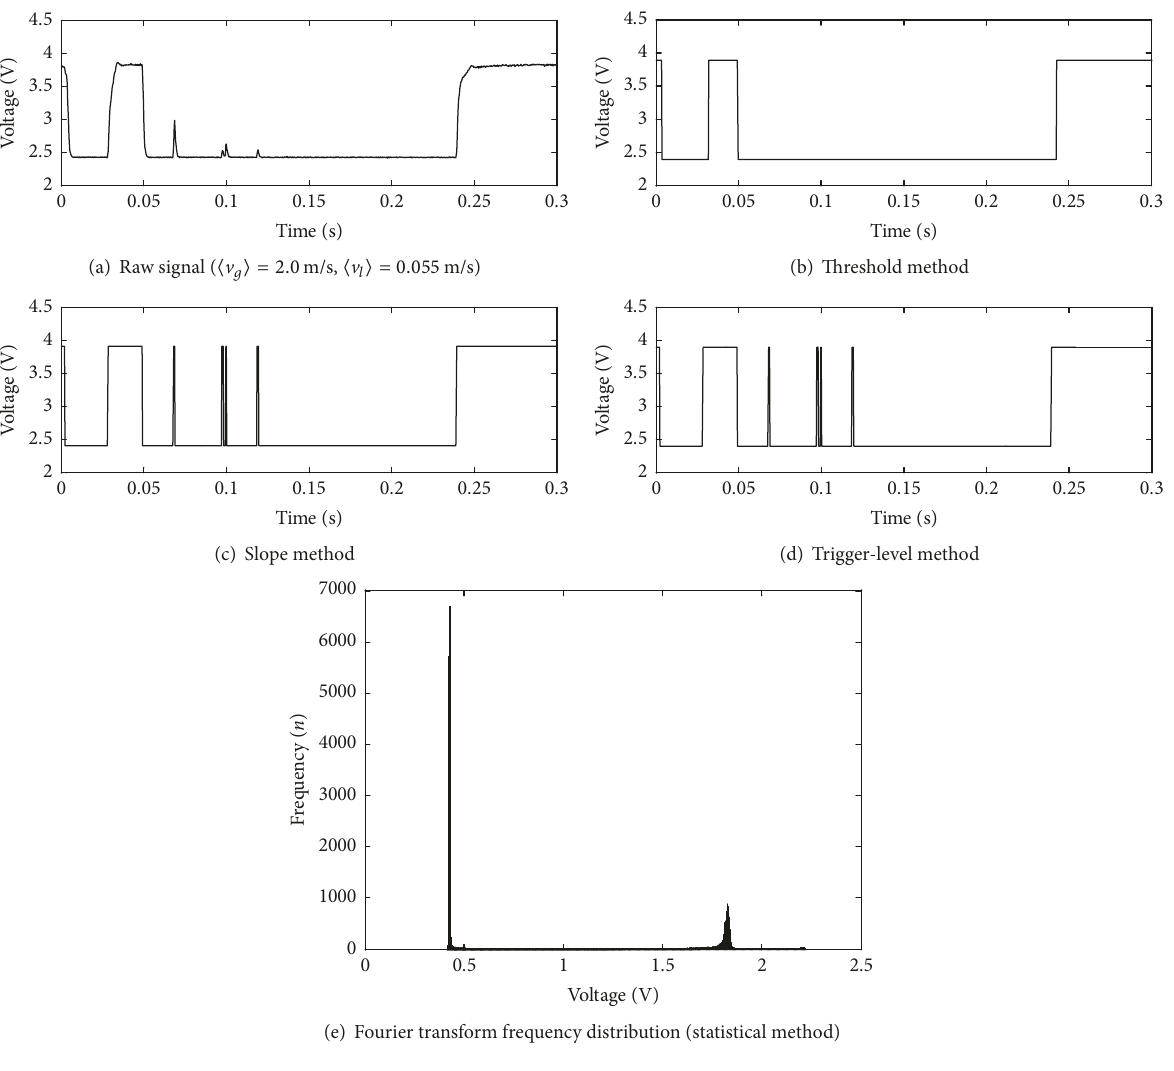
Figure 18: Raw signal and data processing